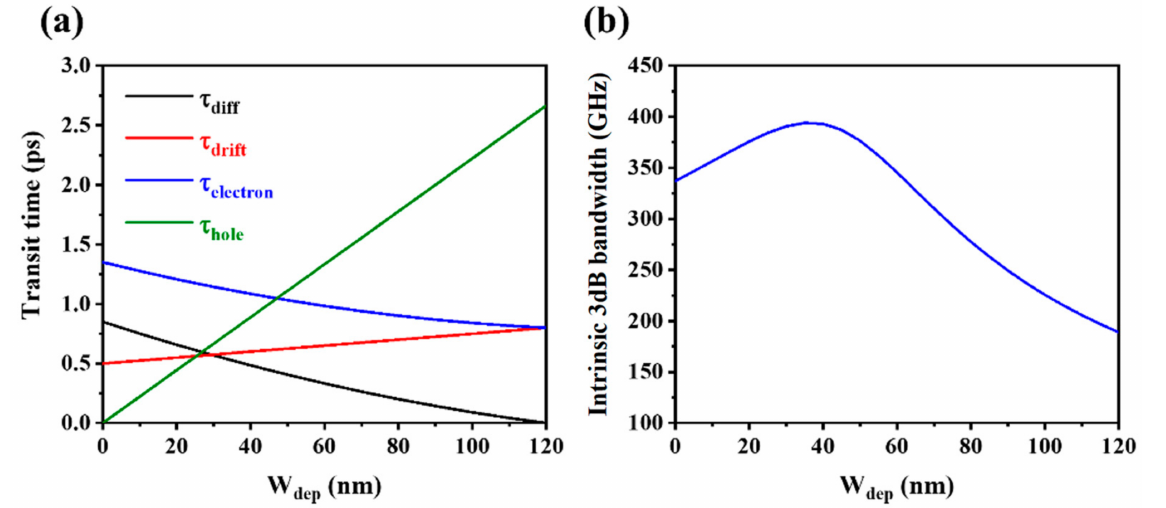
Figure 2. ( a ) Calculated electrons and holes transit time in the MUTC-PD as the depleted absorber layer thickness varied from 0 to 120 nm. ( b ) Corresponding intrinsic 3 dB bandwidth calculation results (low optical power